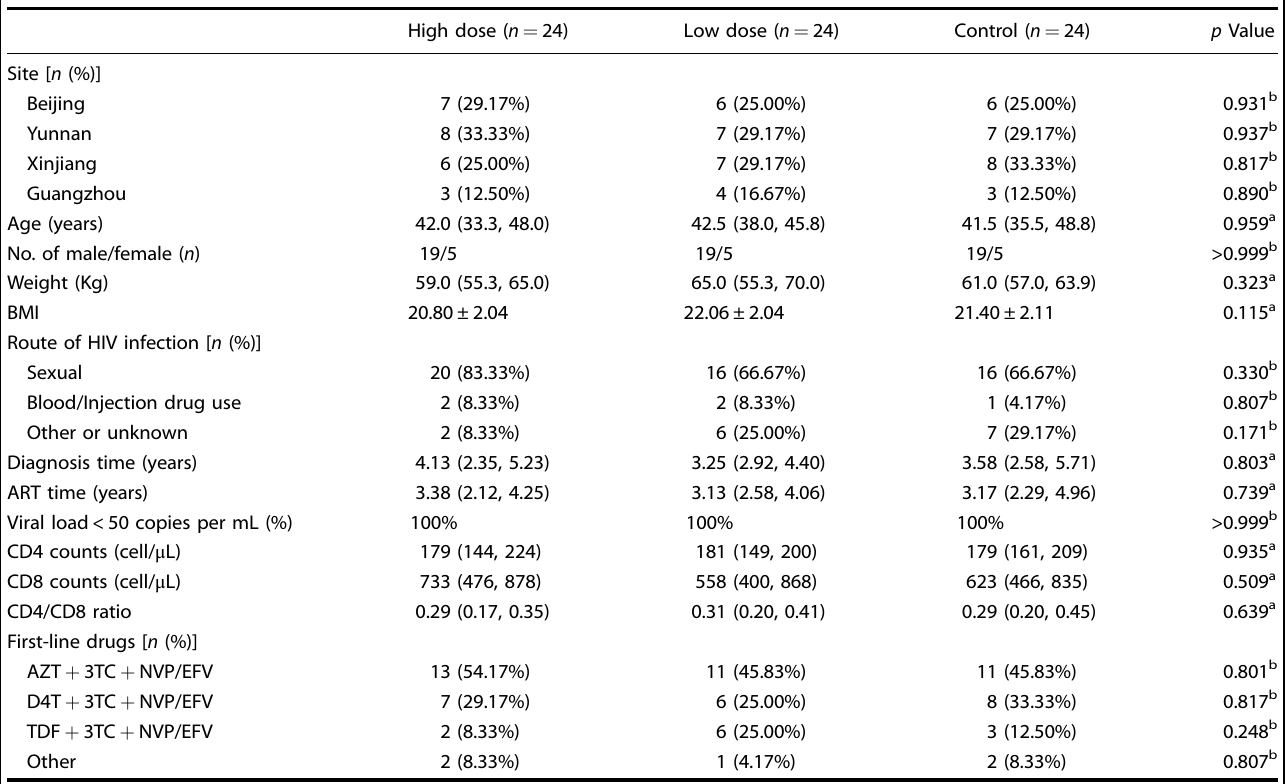
Table 1. Baseline